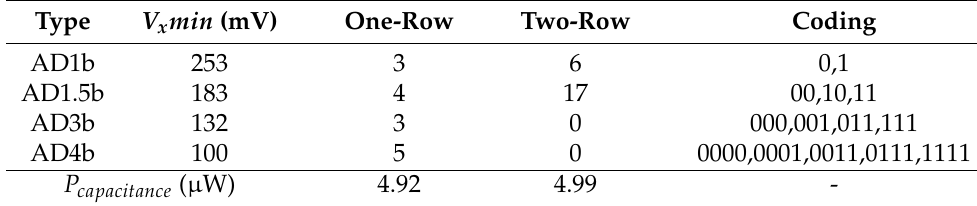
Table 2. Number of ADs and total P capacitance in two